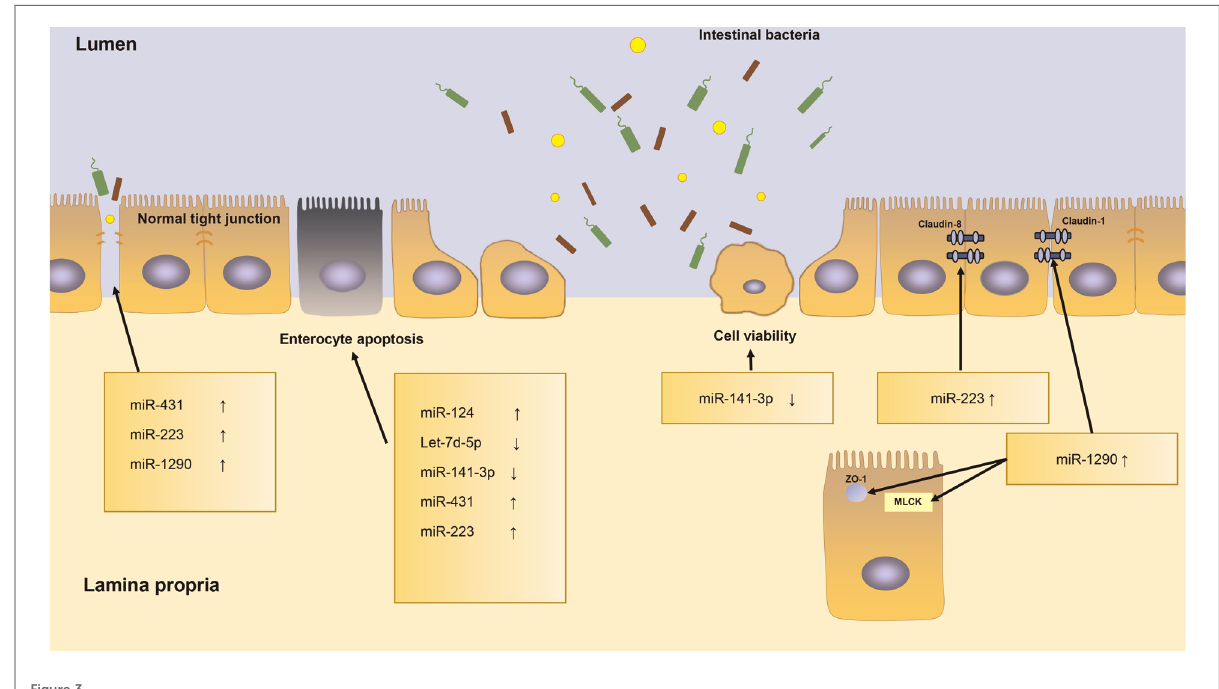
Figure 3 The roles of miRNAs in regulating intestinal barrier